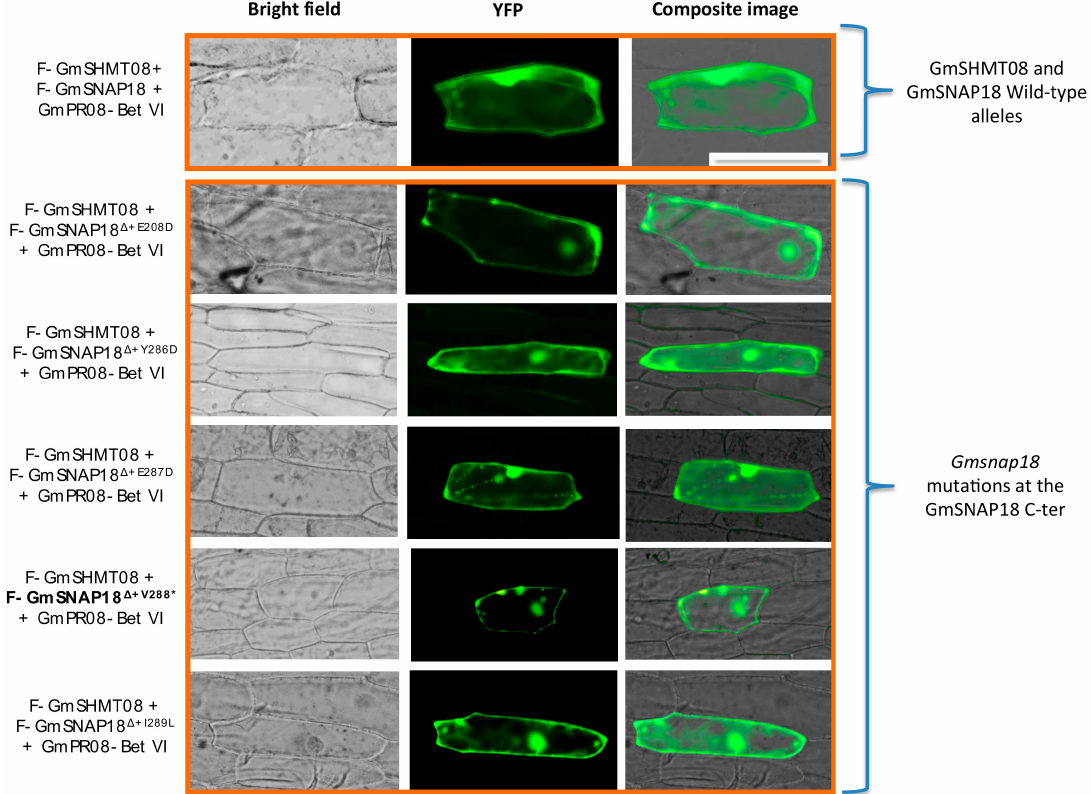
Figure 6. BiFC analysis between GmSHMT08, GmPR08, and the six GmSNAP18 mutant alleles. The coding sequence of the six GmSNAP18 mutant alleles were cloned into pSAT4-nEYFP-C1-B to generate nEYFP-SNAP18 fusions. Likewise, GmSHMT08 and GmPR08-Bet VI from the Forrest-WT were cloned into pSAT4-cEYFP-C1 and pG2RNAi2 to generate cEYFP-GmSHMT08 and cEYFP-GmPR08-Bet VI fusions. Various combinations of cEYFP and nEYFP control fusions were co-expressed in onion epidermal cells by particle bombardment (Figure S2). Bar = 200 µ